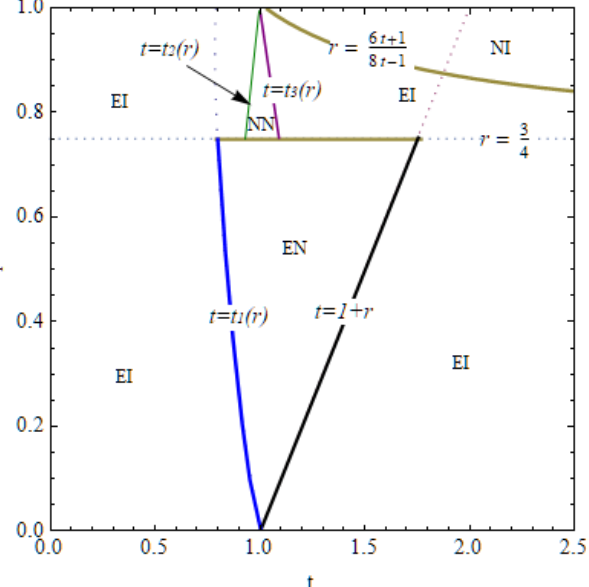
Fig. 3. The equilibrium outcome of the whole